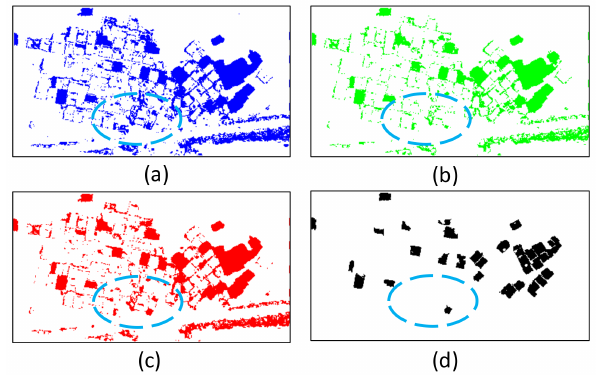
Figure 7. Binary classification by nDSM and dDSM and changed building object extraction by graph cuts. ( a ) Thresholds of nDSM and dDSM are set to 2.2 and 0.5 m, respectively. ( b ) Thresholds of nDSM and dDSM are set to 2.2 and 2.2 m, respectively. ( c ) Changed building area extraction by graph cuts. ( d ) Candidate changed building object formation by region